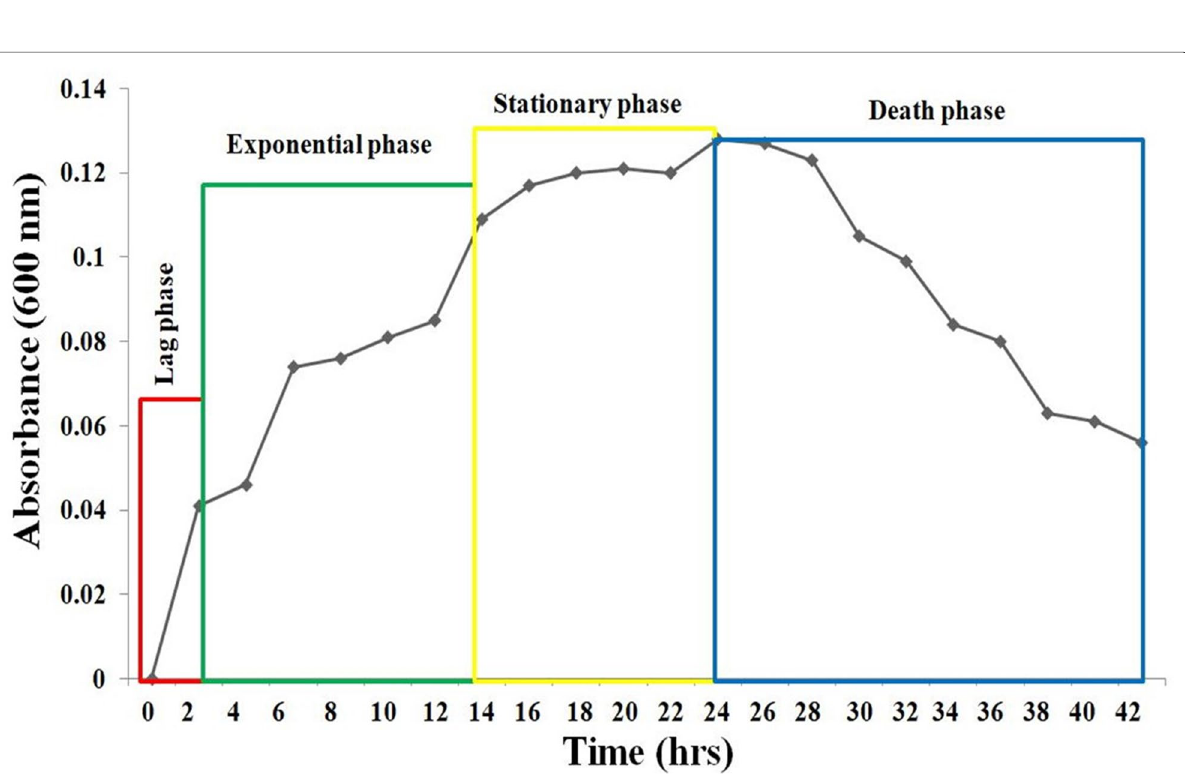
Fig. 4 Growth curve of the bacterial strain